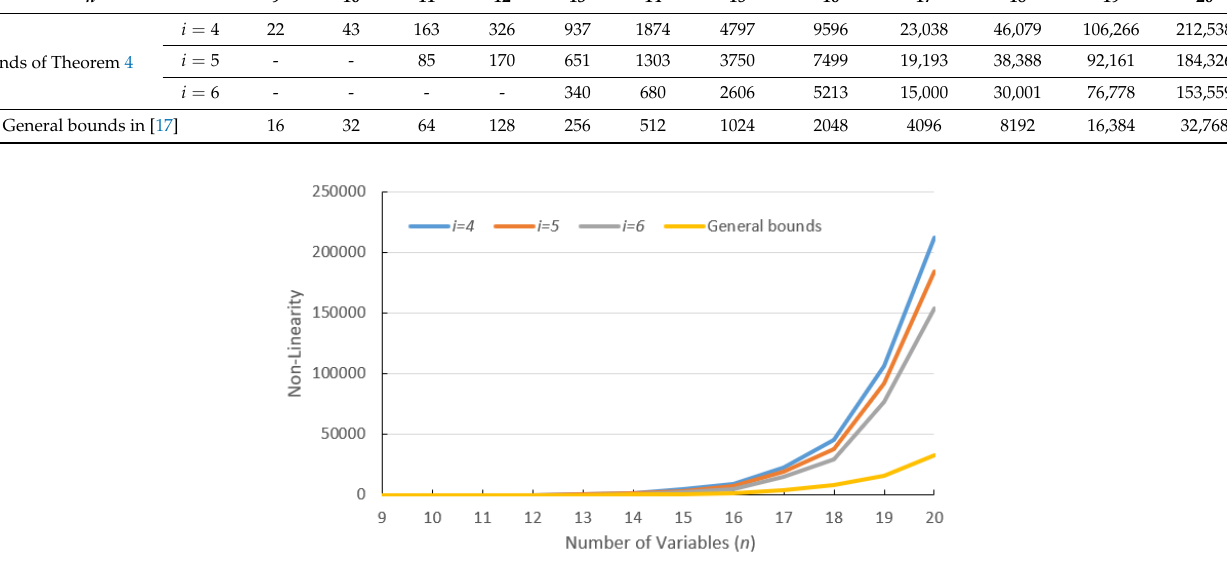
Figure 2. Bounds obtained in Theorem 4 for i = 4, i = 5, i = 6, and general bounds in